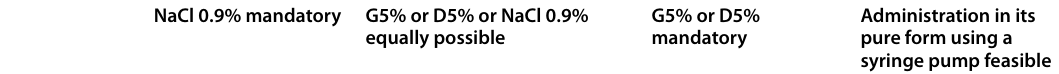
Table 2 Most used medication in the intensive care unit to be diluted for continuous infusion, slow bolus administration or both. The stability of the diluted product is dependent on its end concentration and environmental temperature. The product’s stability in its compatible diluent has been confirmed for the conventional administration times and volumes. For detailed data, we refer to each drug’s SmPC (summary of product characteristics) or relevant